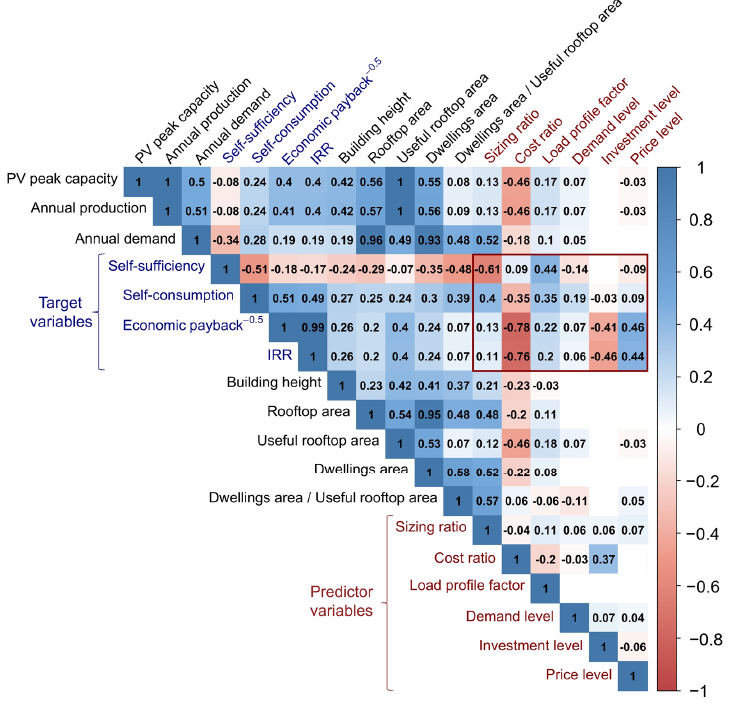
Figure 12. Correlation matrix of the main PVSC variables, physical characteristics of the buildings and assessed techno-economic scenarios.